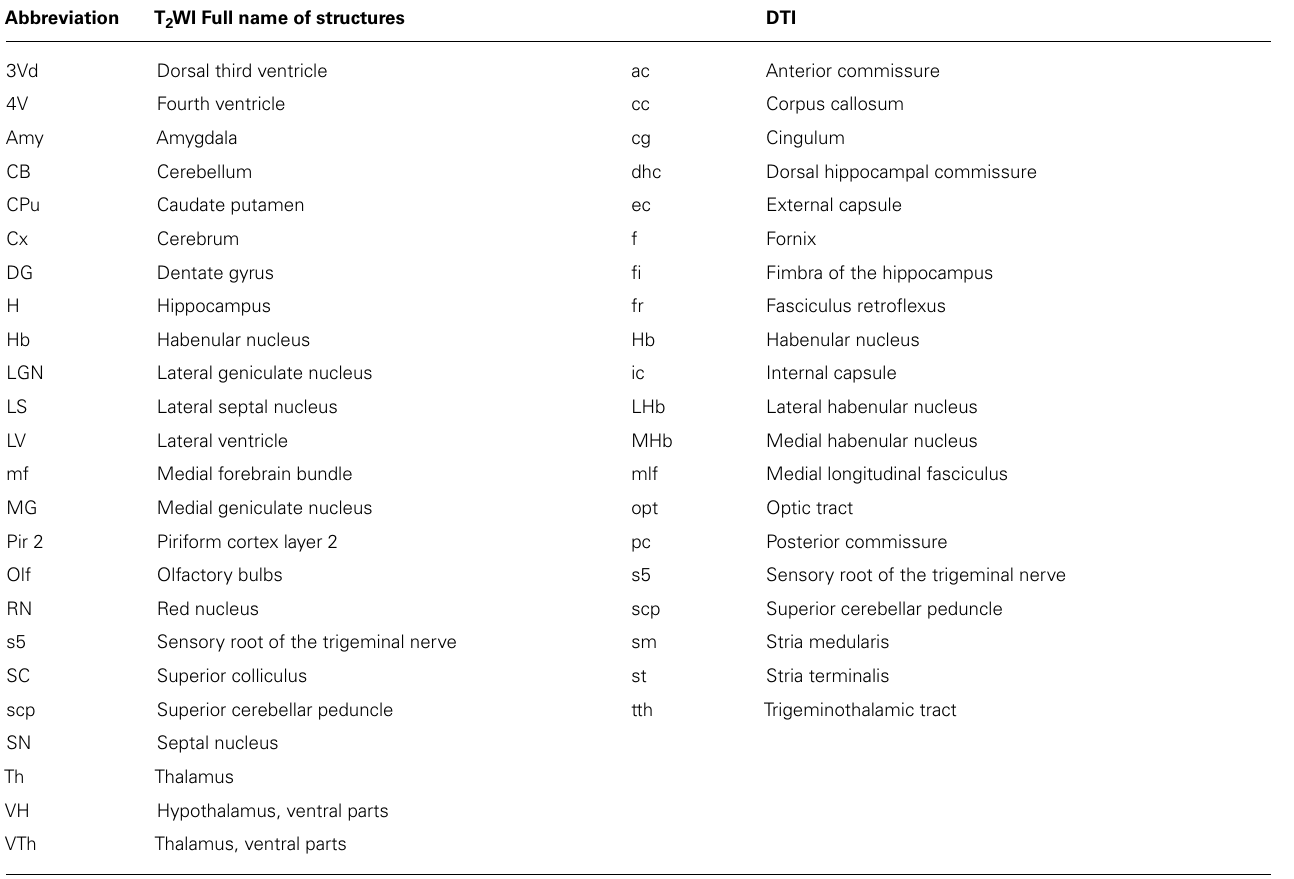
Table 2 |Alphabetical lists of all abbreviations with corresponding structures; left,T 2 WI; right; DTI.